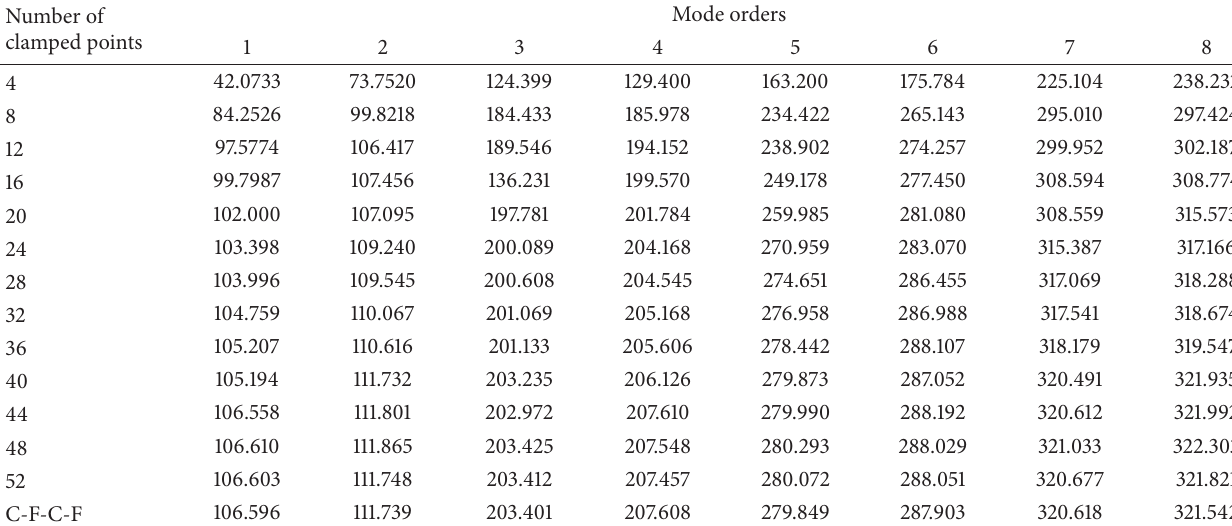
Table 6: First eight frequencies (Hz) for an open cylindrical shell with multipoints clamped-supported on the two edges 𝛼 = 0 and 𝛼 = 𝐿 𝛼 . Number of